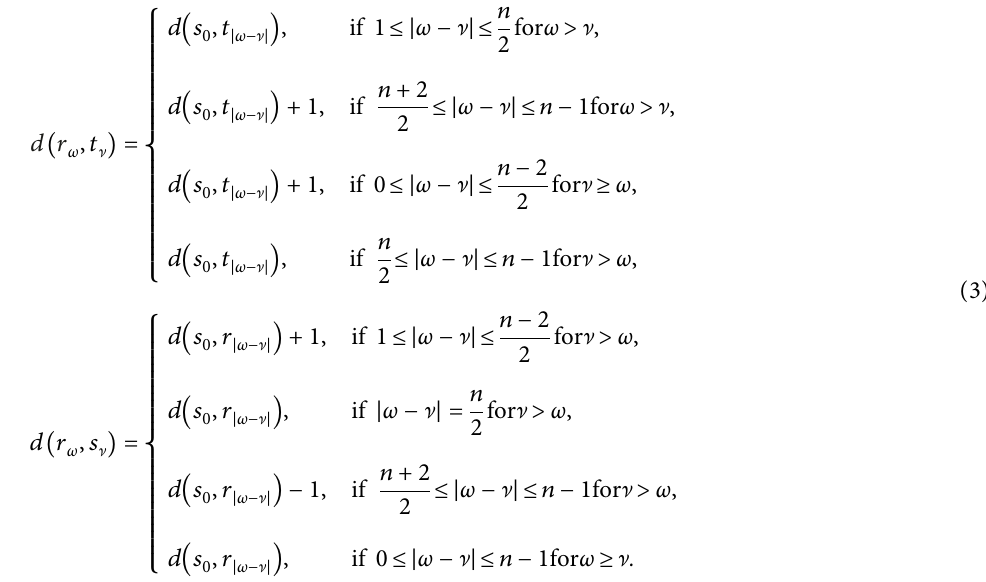
Table 3 shows that the representation r ( g , D ) − r ( g , D ) ≠ 0 for any two T n T n 1 2